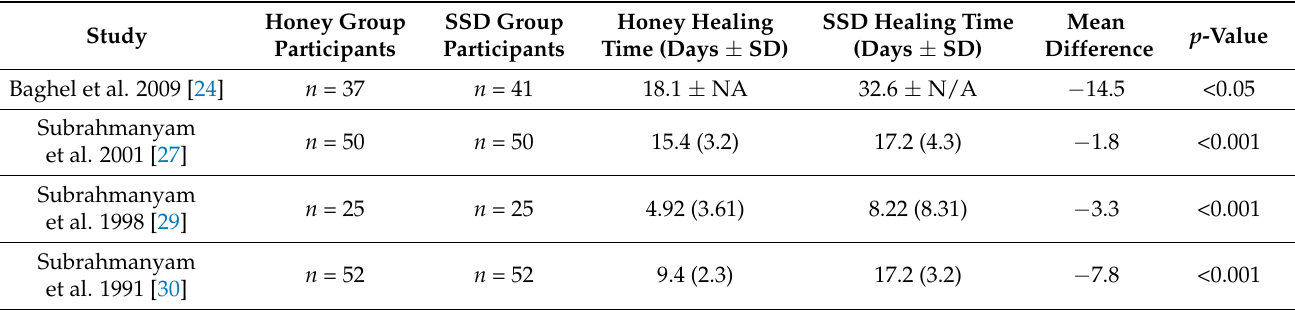
Table 3. Complete Wound Healing Time Results.